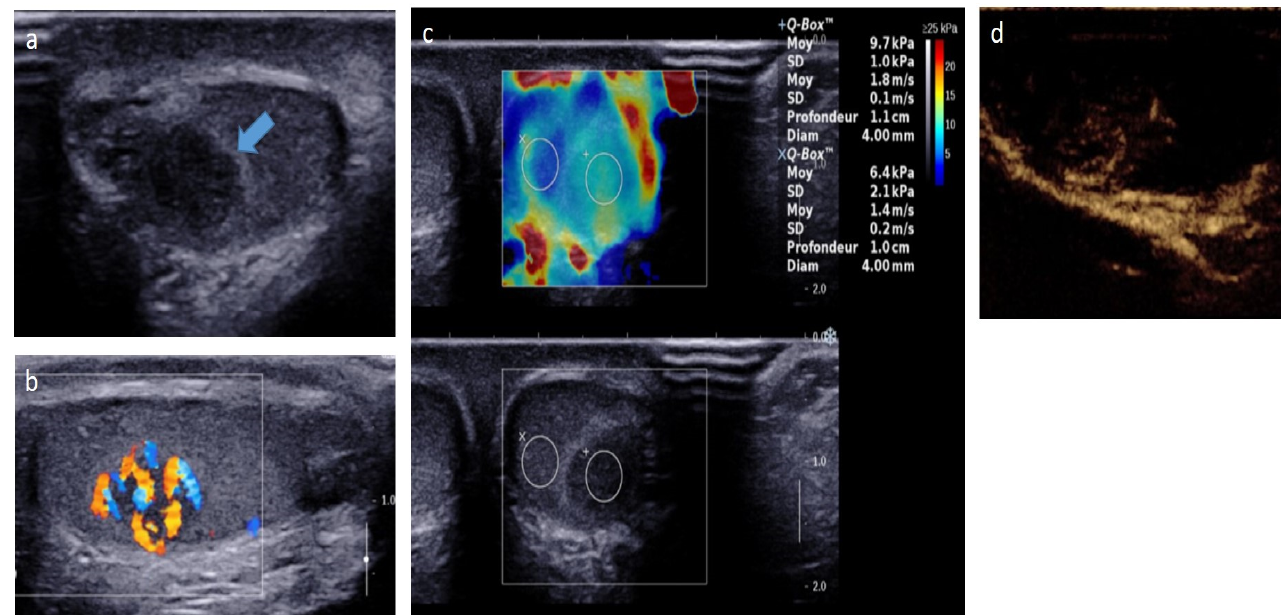
Figure 5. Leydig-cell tumor in an 8-year-old boy. Transverse gray-scale B-mode ( a ) and longitudinal color Doppler ( b ) US of the testis. Shear wave elastography cartography ( c ) and contrast-enhanced US focused on the lesion ( d ). Images show a well-circumscribed hypoechoic mass with intrinsic central and peripheral hypervascularization, surrounded by a hyperechoic rim (blue arrow) with moderate increased stiffness on elastography. The patient was referred for early pubic hairiness and accelerated growth rate. Testosterone level was increased, and gonadotrophin levels (follicle-stimulating hormone, luteinizing hormone) were low. The patient underwent conservative surgery. US, ultrasonography. Courtesy of Pr Laurence Rocher, Antoine B é cl è re, Clamart, France.